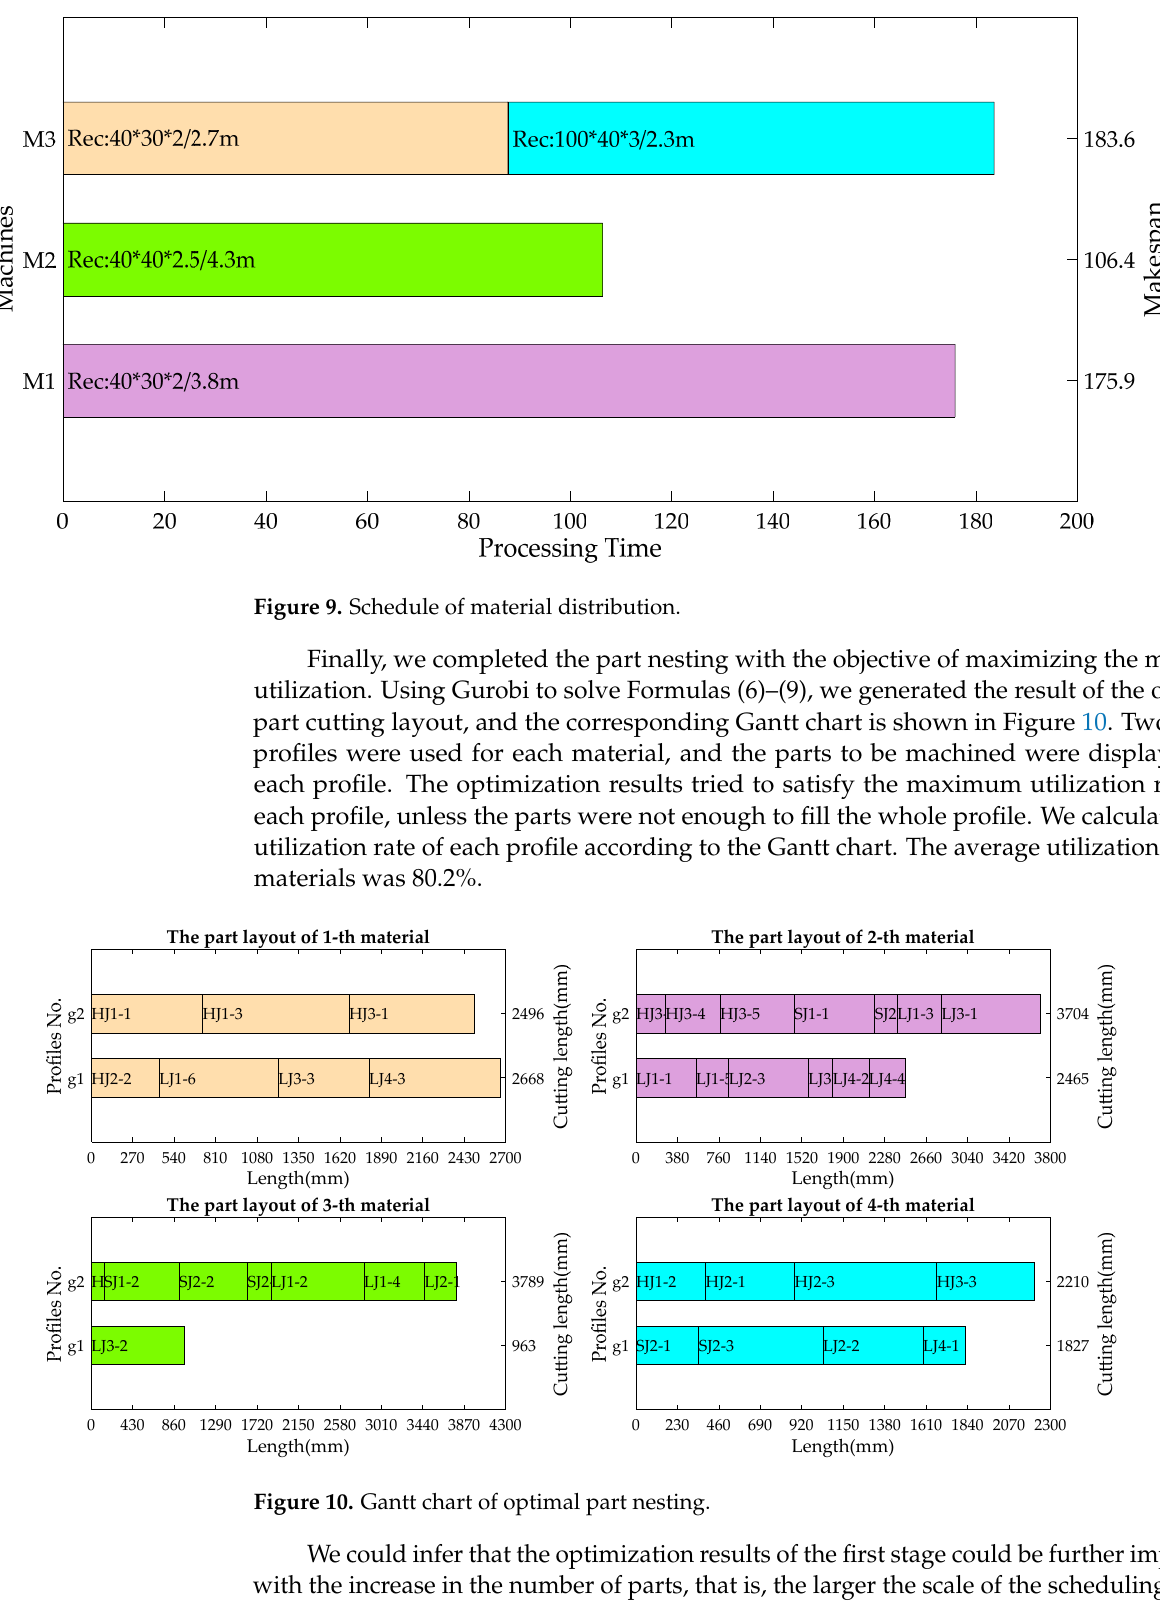
Figure 11. The convergence curves of objectives f 3 1 , f 3 2 and f 3 3 . The part scheduling Gantt chart is shown in Figure 12, and the minimized makespan of the machine was 106.4, corresponding to machine M2. Taking machine M2 as an exam- ple, parts LJ3-2, LJ1-2, LJ1-4, SJ2-4, LJ2-1, HJ1-4, SJ1-2 and SJ2-2 were continuously pro- cessed. Combined with the results of material distribution and part layout, that is, Figures 9 and 10, we could infer that the first part (LJ3-2) belonged to the first profile (g1) of the third material and that the latter six parts belonged to the second profile (g2).